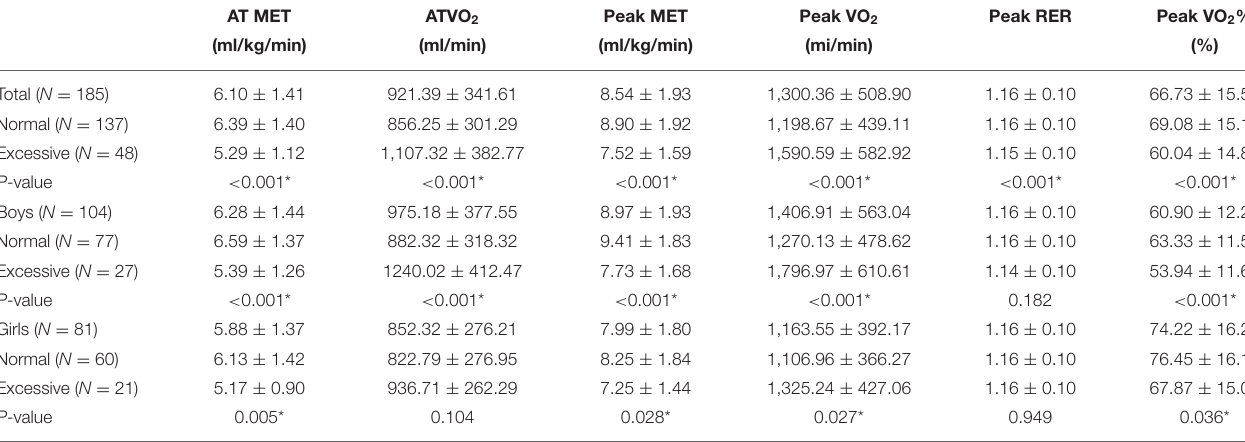
TABLE 4 | Comparisons of cardiopulmonary fitness between patients with repaired tetralogy of fallot with normal and excessive body adipose (FMI group). AT